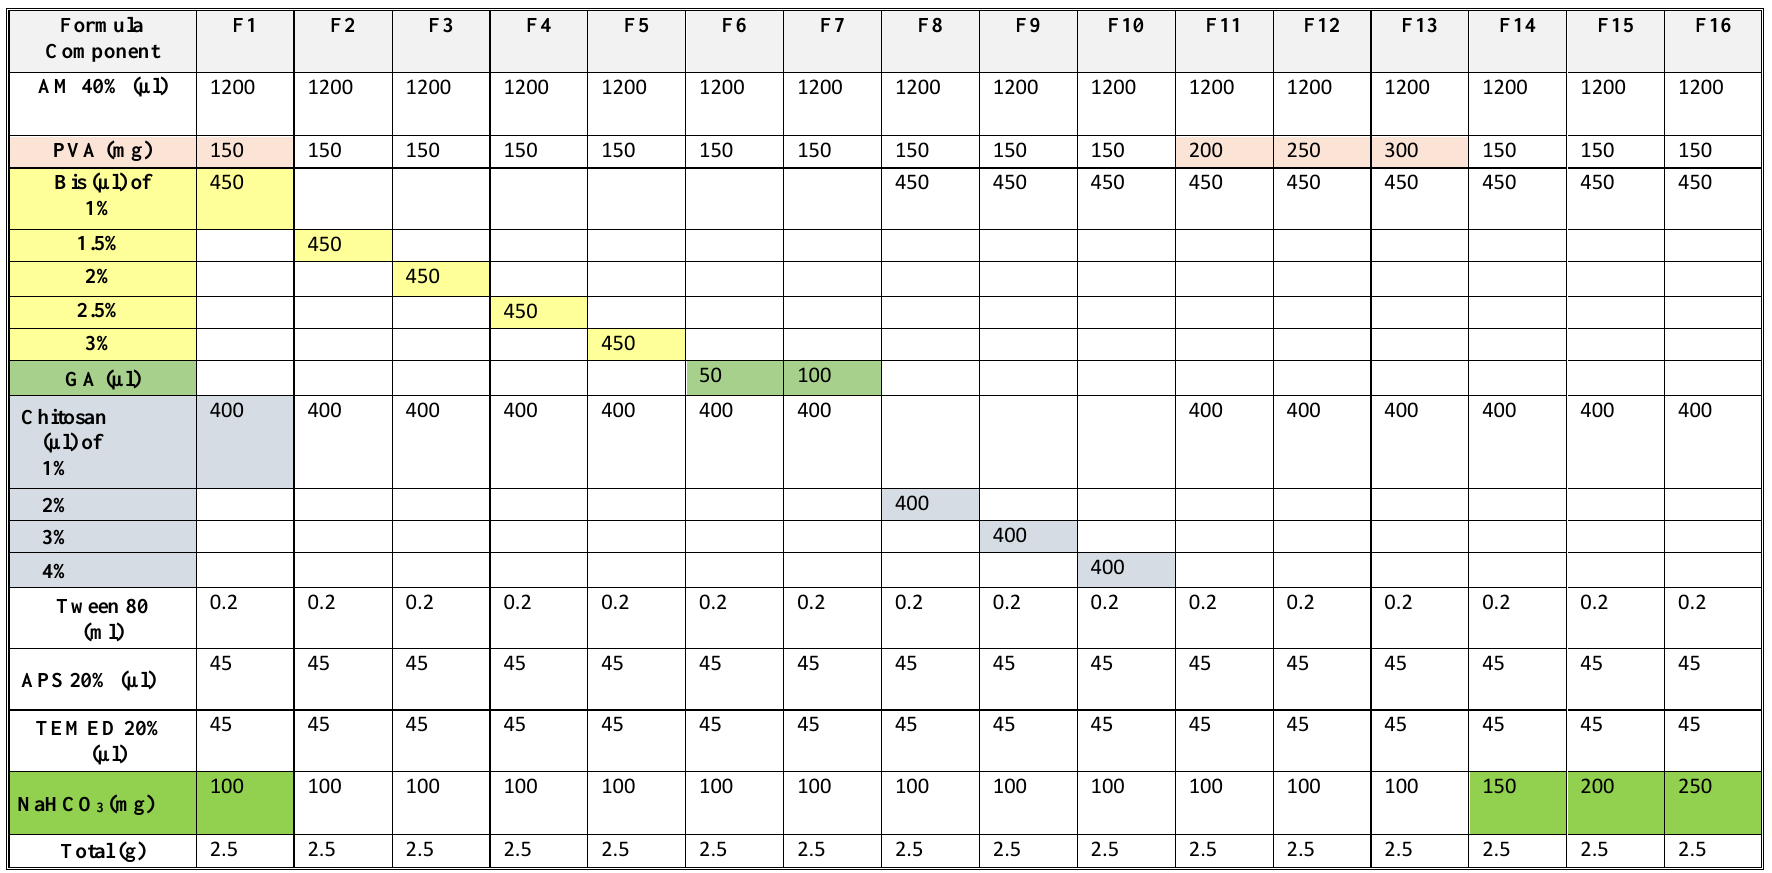
Table 1 ． Formulas of